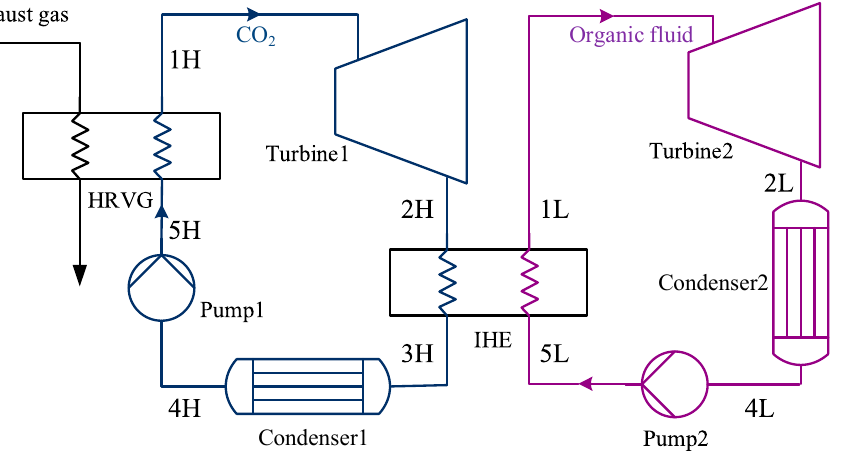
Figure 4. Schematic diagram of CO 2 -TC/OTC combined system.